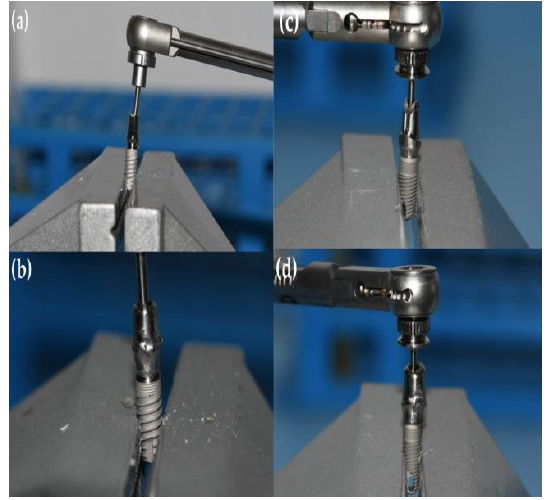
Figure 4. Tightening of the prosthetic abutment. ( a ) GC Aadva Standard implant with original abutment; ( b ) GC Aadva implant with third-party custom-made abutment; ( c ) Zimmer Tapered Screw-Vent implant with original abutment; and ( d ) Zimmer Tapered Screw-Vent implant with third-party custom-made abutment.